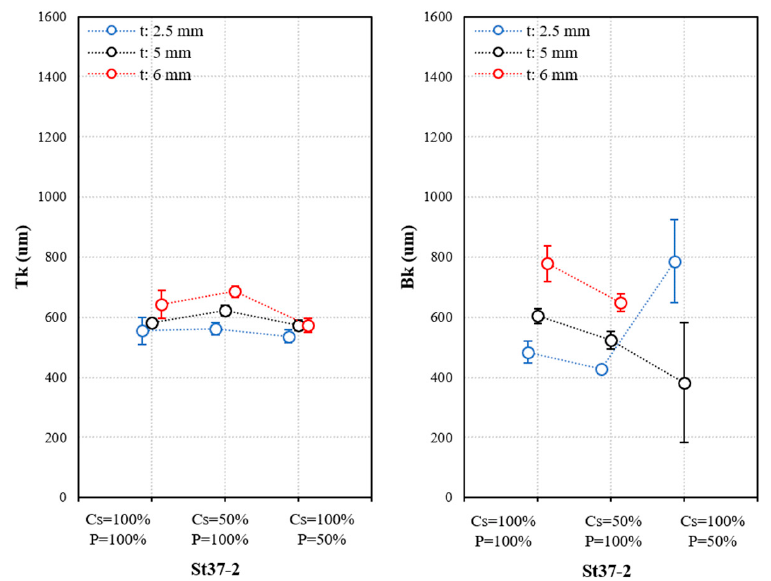
Figure 6. Kerf width for St37-2 in relation to cutting conditions and thickness.